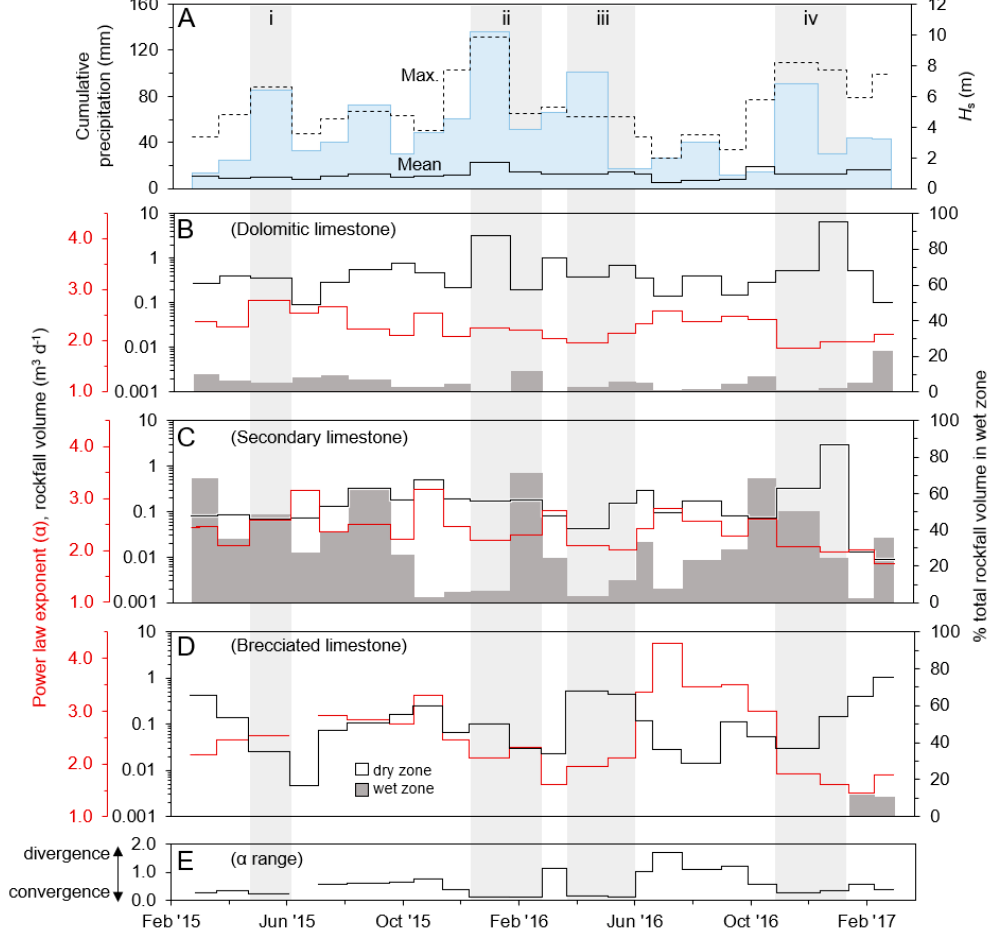
Figure 11. ( A ): Local gauge-based precipitation data, displayed as cumulative total per differencing period (blue), and maximum and mean significant wave heights (H s ) at the Newbiggin wave buoy (dashes and solid line, respectively.) ( B – D ): Proportional rockfall distribution in the ‘wet’ and ‘dry’ zones on the cliff face (i.e., rockfalls occurring below and above the tidal inundation threshold for each differencing epoch, respectively), daily rockfall volume (black line) and the power law exponent of the rockfall inventory (red line) per differencing period. ( E ): Divergence/convergence of the exponent ( α ) of the power law exponent that best describes the cumulative distribution function of the rockfall inventory for each lithology, represented as the max-min exponent range between lithologies. i–iv highlight differencing periods that include notable storm events, wherein we observe convergence of α and direct or lagged erosion response in one or more lithologies.